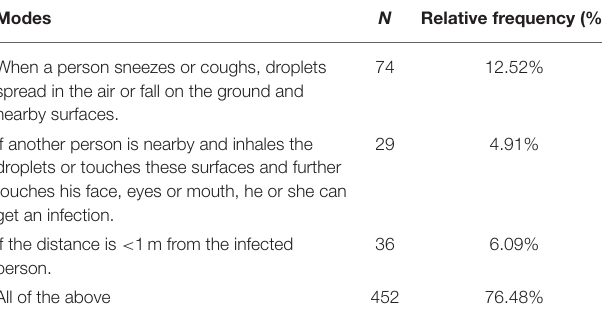
TABLE 4 | Relative frequencies (%) related to COVID-19 transmission.